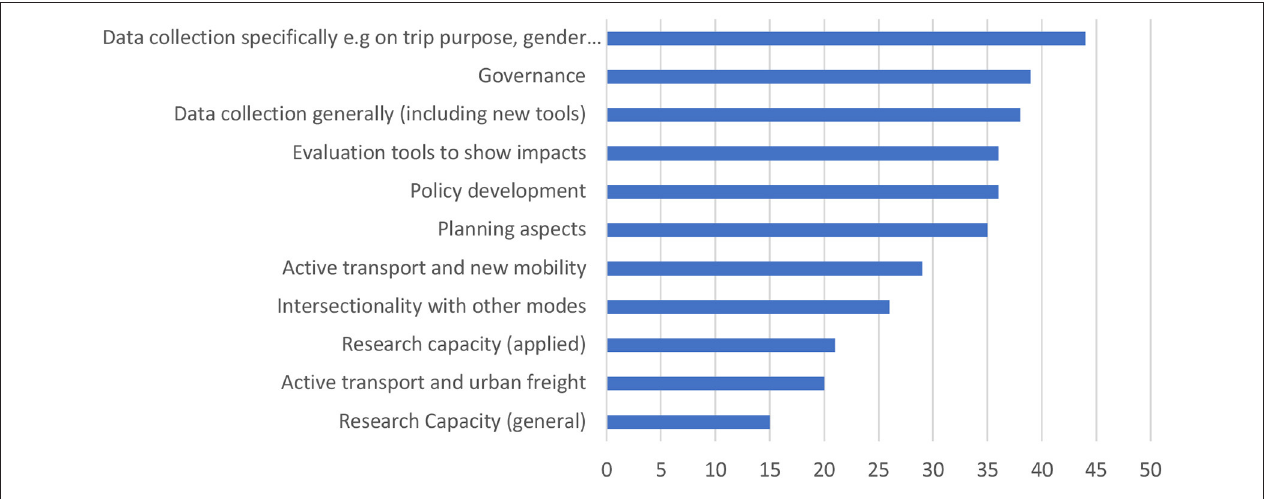
FIGURE 2 | Respondents’ ranking of research